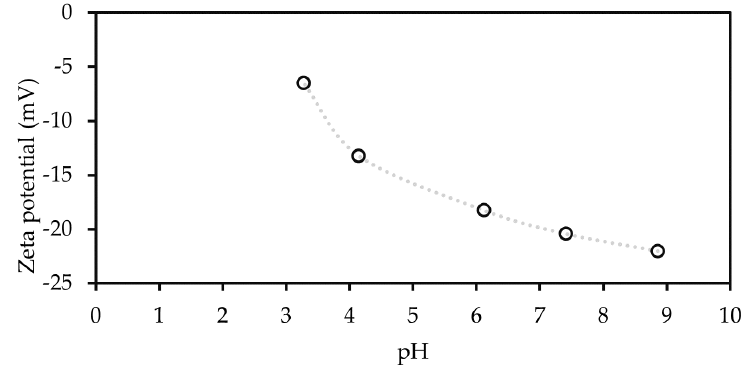
Figure 6. Surface charge of the CNFs particles.